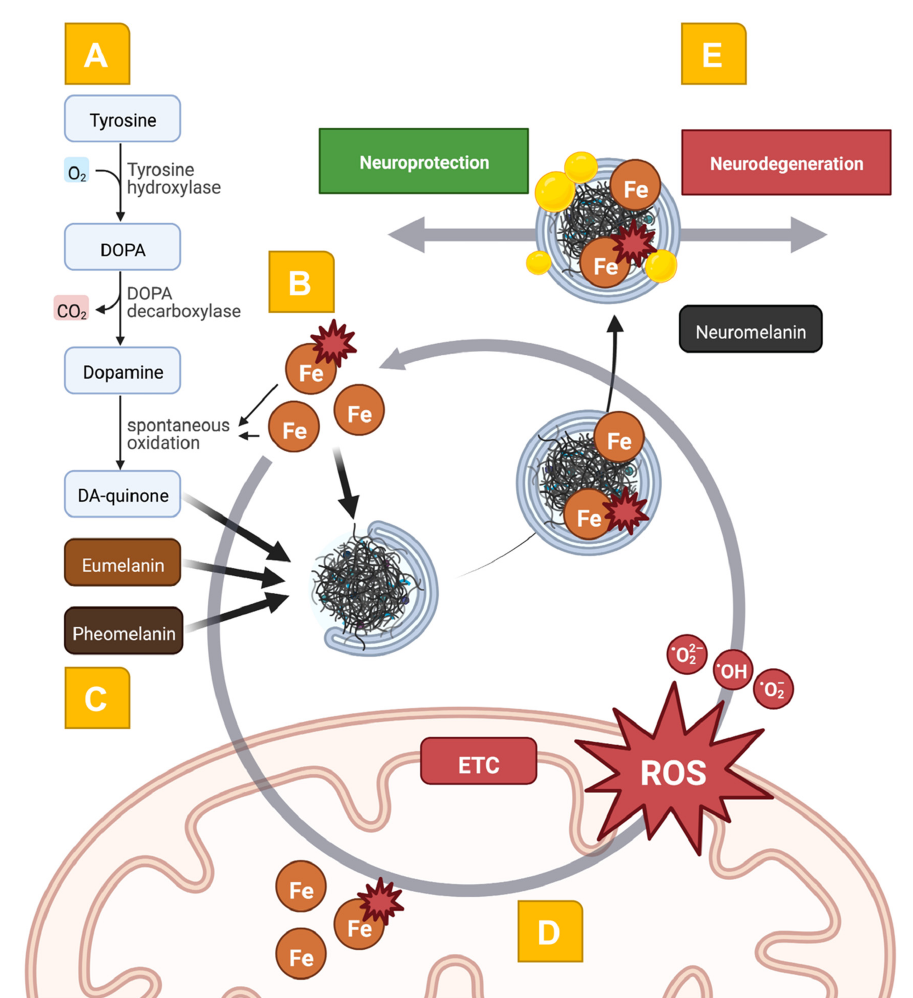
Figure 1. Schematic representation of the interwovenness of DA metabolism, iron, neuromelanin, and mitochondrial dyshomeostasis in the pathophysiology of PD. In Panel ( A ), the spontaneous oxidation of DA leads to the generation of the toxic DA-quinone. This process is further enhanced by the presence of ROS and a disbalance between ferrous and ferric iron ( Panel ( B )). The macromolecular organization of eumelanin and pheomelanin with DA-quinone leads to neuromelanin formation ( Panel ( C )). Here, macroautophagy-related mechanisms and the fusion with lysosomes and autophagic vacuoles form the complex macromolecule neuromelanin. Covalently bound lipids (depicted as yellow droplets) and peptides change the structure of neuromelanin over a lifetime, also in normal aging. In Panel ( D ), the exceeding import of iron and the improper assembly of iron-containing biomolecules (e.g., the ETC complexes) leads to bioenergetic disturbances and the generation of ROS. These mechanisms form a vicious cycle leading to neurodegeneration. Interestingly, the neuromelanin molecule has opposing roles in the pathophysiology of PD ( Panel ( E )): the complexation of damaging molecules serves as a neuroprotective mechanism via the reduction of oxidative stress. ETC: electron transport chain, Fe: iron, ROS: reactive oxygen